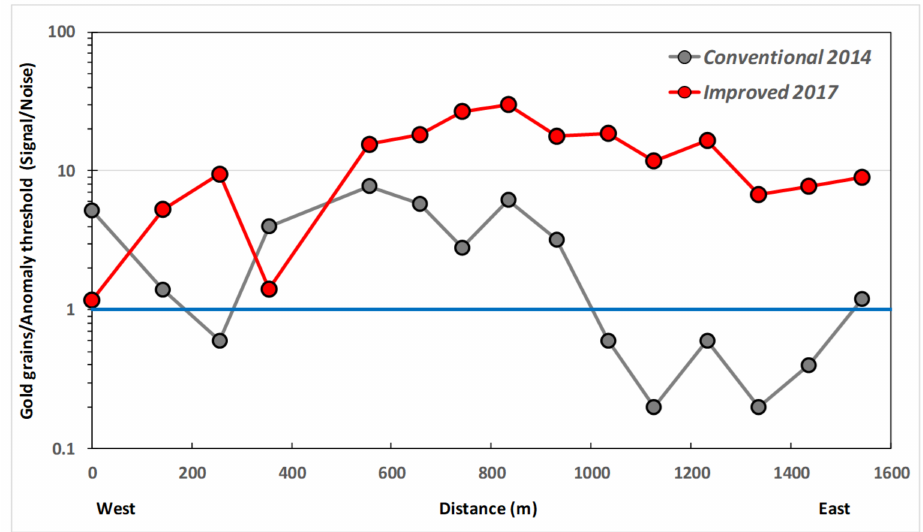
Figure 12. Comparison of gold grain counts normalized to the anomaly threshold for the conventional and improved methods along the profile of the 15 paired samples. It should be noted that there is a logarithmic vertical scale, while the horizontal scale represents the distance away from the westernmost